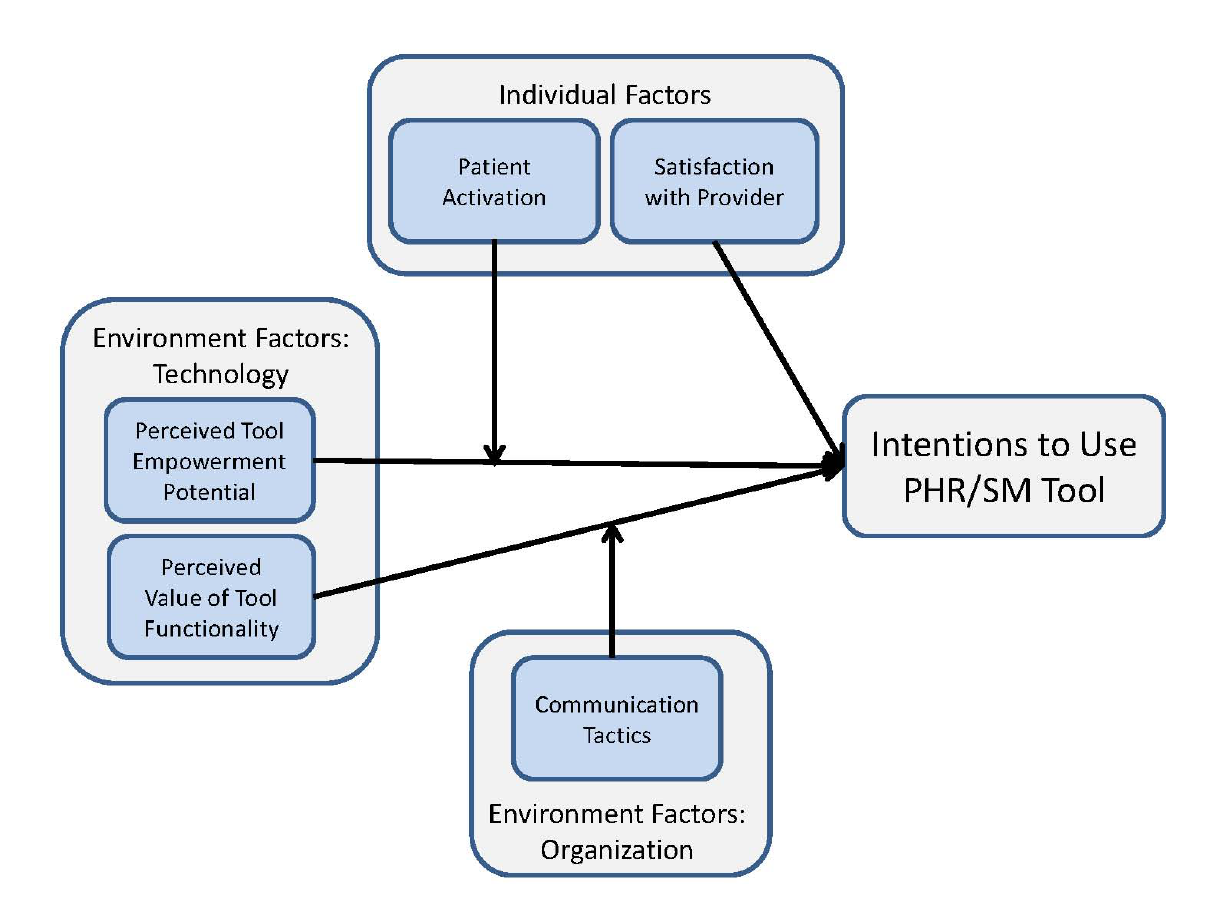
Figure 1. PHR acceptance